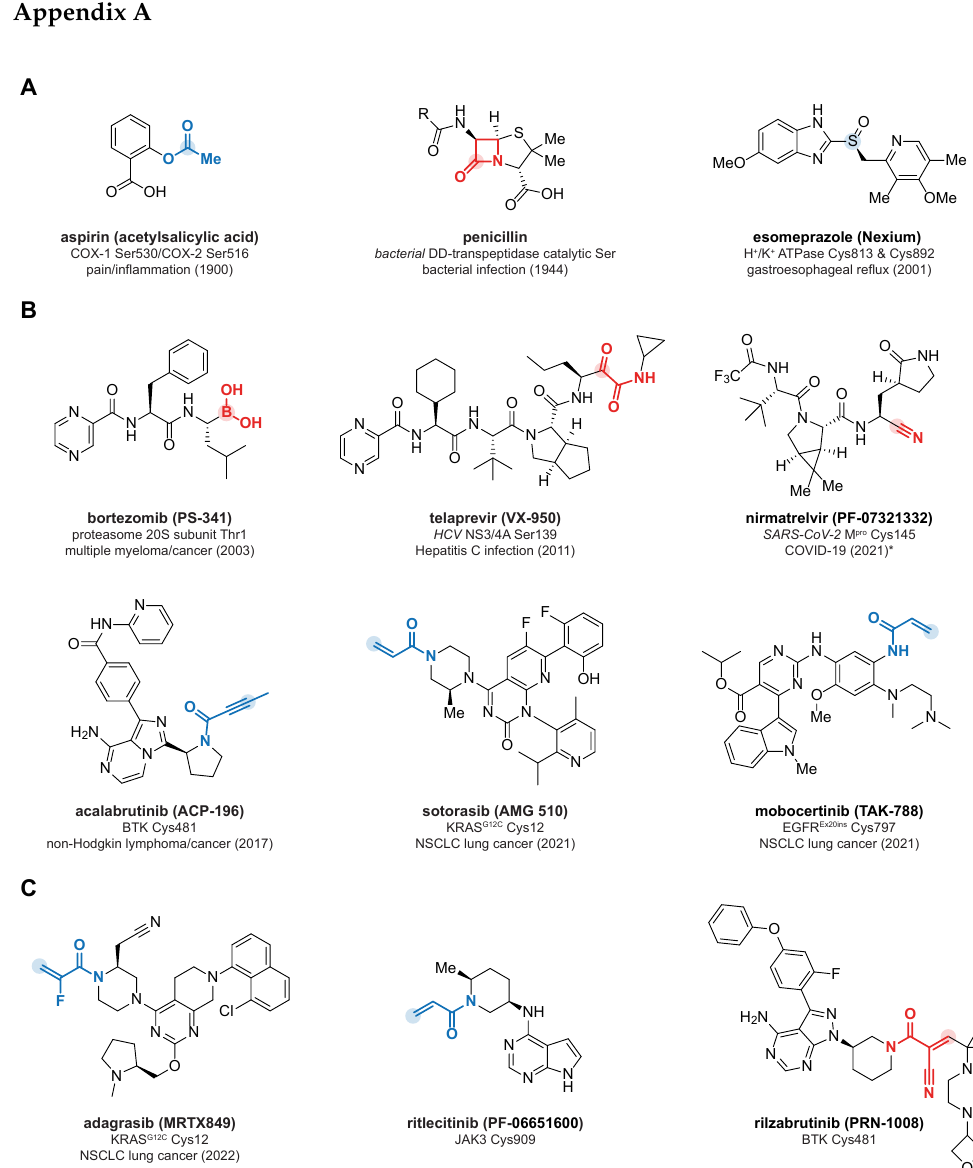
ON N N Figure A1. Drugs with a known covalent binding mode. Structure with reversible warheads in red, irreversible warheads in blue, and the covalently modified atom marked. Compound name; protein target and covalently modified amino acid; therapeutic application and year of first clinical approval. ( A ) Approved covalent inhibitors that were later found to have a covalent binding mode. Warhead not indicated for esomeprazole: metabolic activation of the prodrug precedes formation of a disulfide bond with its target [6]. ( B ) Approved targeted covalent inhibitors (TCIs) designed to covalently modify their protein target. ( C ) Covalent inhibitors with a novel protein target and/or